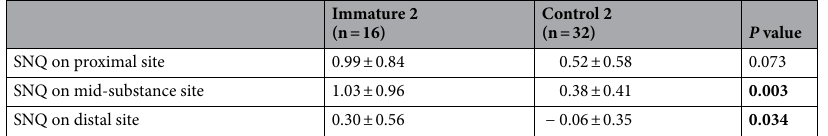
Table 4. Comparison of signal-to-noise quotient of reconstructed anterior cruciate ligaments between the immature 2 and control 2 groups. A t-test was used. SNQ signal-to-noise quotient. The bold values represent the significant difference, which p values were less than